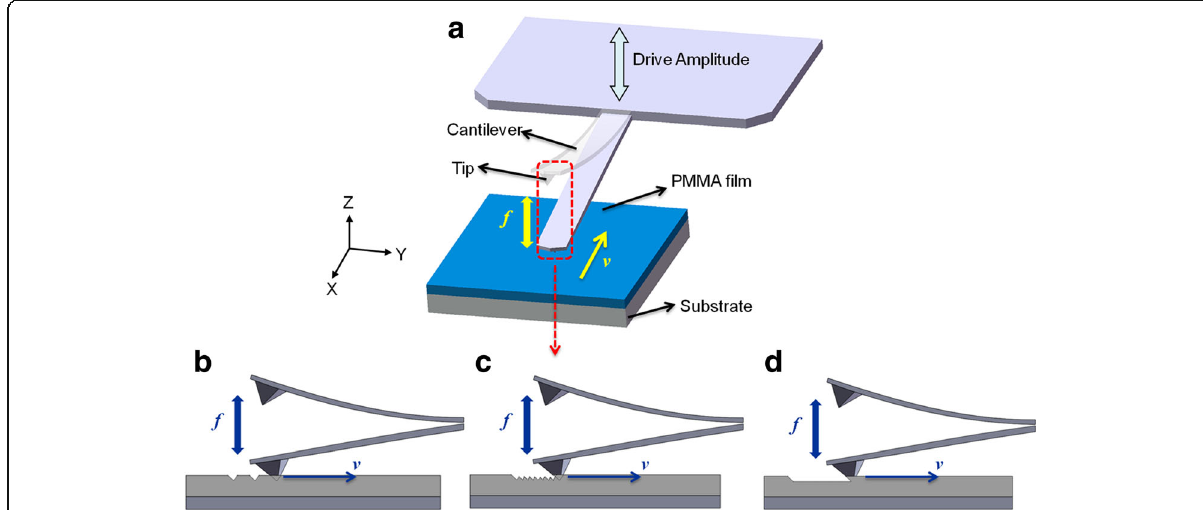
Fig. 1 a Schematic of the line scratching process on PMMA film surface with the FSN method. The cantilever is oscillating at its resonance frequency f in the vertical direction. The scratching velocity v is modified along the fast scan direction. Various scratching velocity ranges are depicted: b high scratching velocity, c medium scratching velocity, and d low scratching